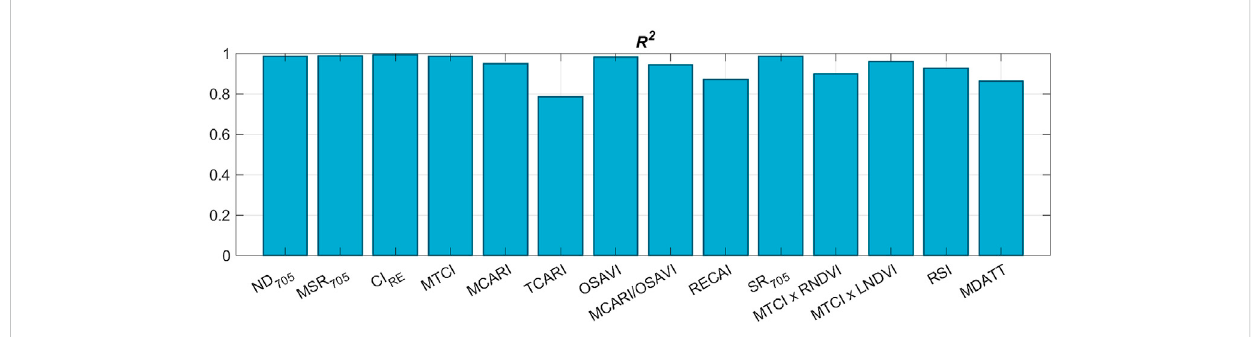
FIGURE 5 Coef fi cient of determination R 2 of linear correlation between average values of calculated CIs and reference CCs for all experimental plants.